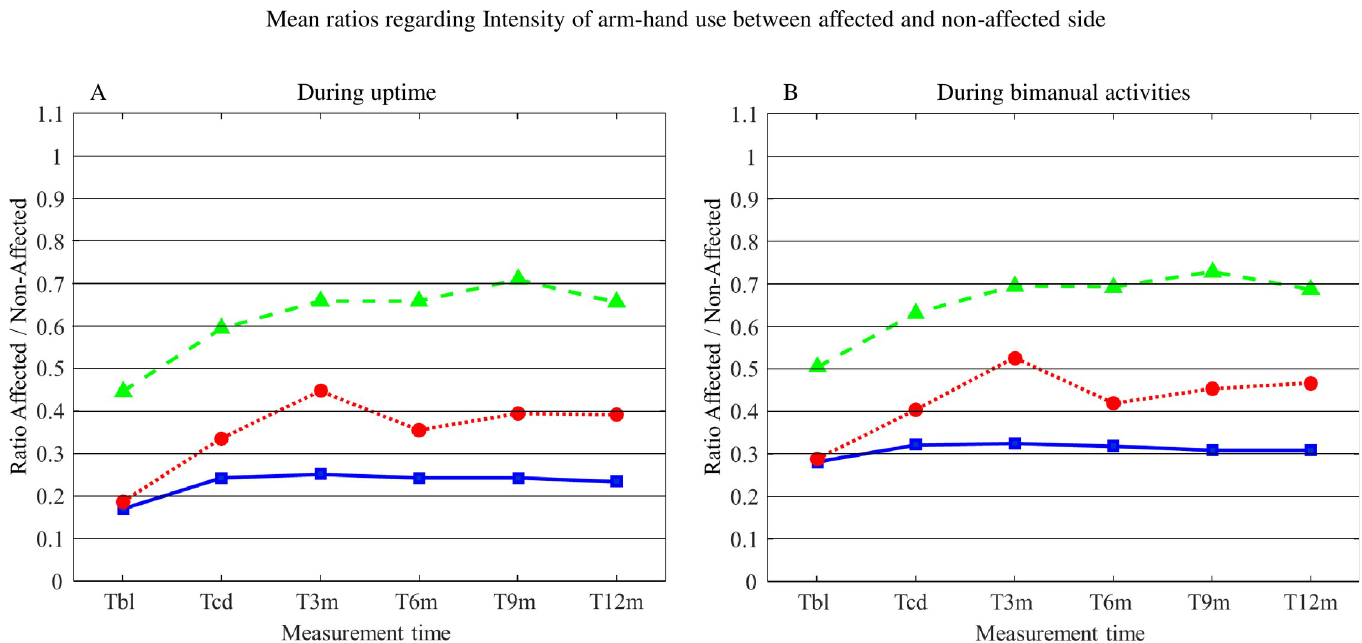
Fig 6. A: Mean ratios regarding Intensity of arm-hand use between the affected and the non-affected arm-hand during uptime for subgroups 1, 2 and 3. B: Mean ratios regarding Intensity of arm-hand use between the affected and the non-affected arm-hand during bimanual activities for subgroups 1, 2 and 3. T = time; bl = baseline; cd = clinical discharge; m = month; A = affected side; NA = non-affected side. Solid line = subgroup 1; Dotted line = subgroup 2; Dashed line = subgroup 3.